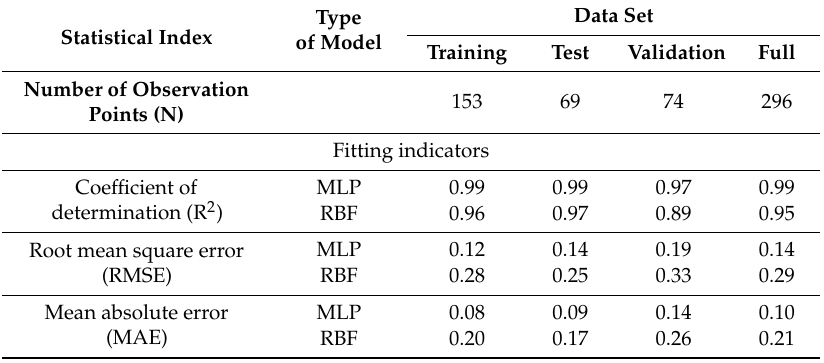
Table 4. Statistical criteria used to evaluate the prediction accuracy of MLP and RBF neural